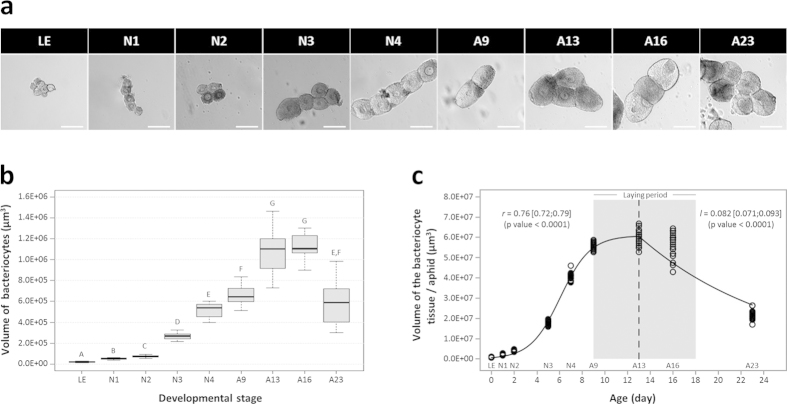
Dynamics of the bacteriocyte size during aphid development.(a) Representative microscopy images of bacteriocyte cells at different developmental stages. Scale bars = 100 μm. (b) Variation in the volume of bacteriocytes, in relation to aphid developmental stage. Results are displayed as box plots where central lines represent the medians, boxes comprise the 25–75 percentiles and whiskers denote the range; n > 10 aphids per stage, for a total number of more than 4,000 bacteriocytes isolated and analyzed. Data were analyzed by the Kruskal-Wallis test, followed by a post hoc multiple comparisons test (Wilcoxon rank-sum test with Bonferroni correction). Developmental stages labeled with different letters are significantly different (P < 0.05). (c) Modeling of bacteriocyte volume dynamics during aphid development. The volume of the bacteriocyte tissue per aphid was determined as the product of the bacteriocyte number by the bacteriocyte mean volume. A logistic model was applied for the first part of the dynamics, followed by an exponentially decreasing model. Volume increasing, r, and decreasing rates, l, are shown on the figure, with their 95% confidence interval. Shaded grey area indicates the laying period.